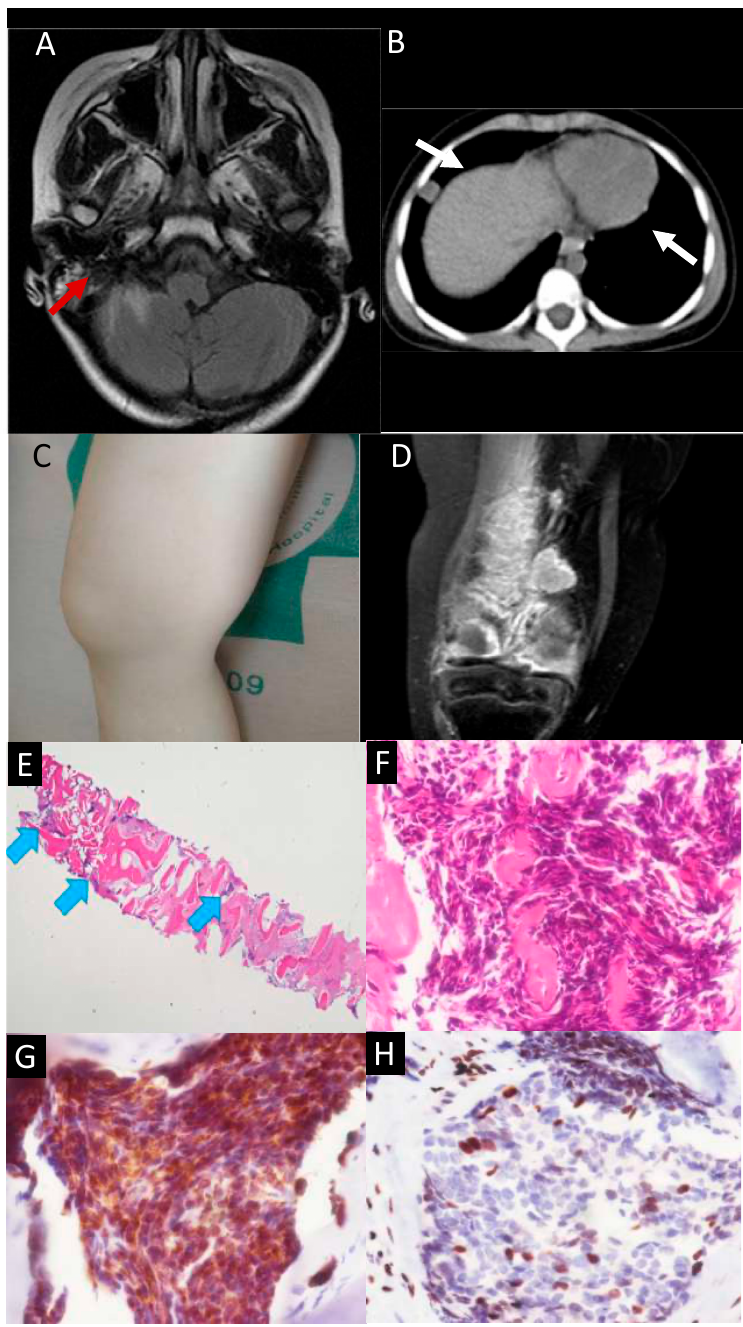
Figure 3. Primary ependymoma with extraneural metastases in ( A ) the mastoid sinus (red arrow) and ( B ) pleura and mediastinum (white arrow). ( C ) Gross appearance of the swelling thigh. ( D ) T1-weighted MR image with contrast of the right femoral bone showing an enhancing tumor mass on the femoral shaft and condyles. ( E ) Bone biopsy specimen showing the foci of metastatic EPN-PFA (blue arrows) (20× magnification). ( F ) The hyperchromatic tumor cells in the bone marrow forming a rosette- like structure on the H&E stain (400× magnification). ( G ) Immunohistochemical stain for GFAP in the neoplastic cells (400× magnification). ( H ) The tumor cells lost the expression of H3K27me3 (compared with other non-neoplastic bone marrow cells that were used as an internal control (400× magnifica- tion).